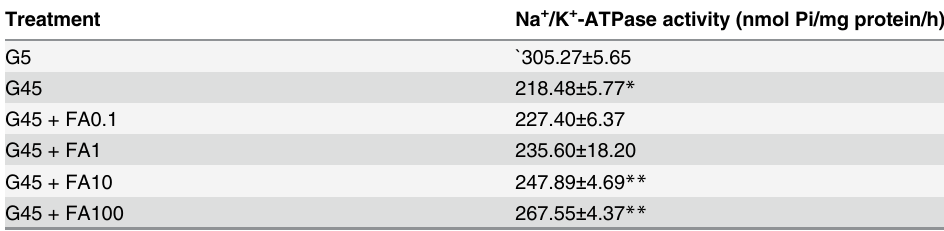
Table 1. The effects of ferulic acid (0.1 – 100 μ M) on Na + /K + -ATPase activity in erythrocytes treated with 45 mM glucose.